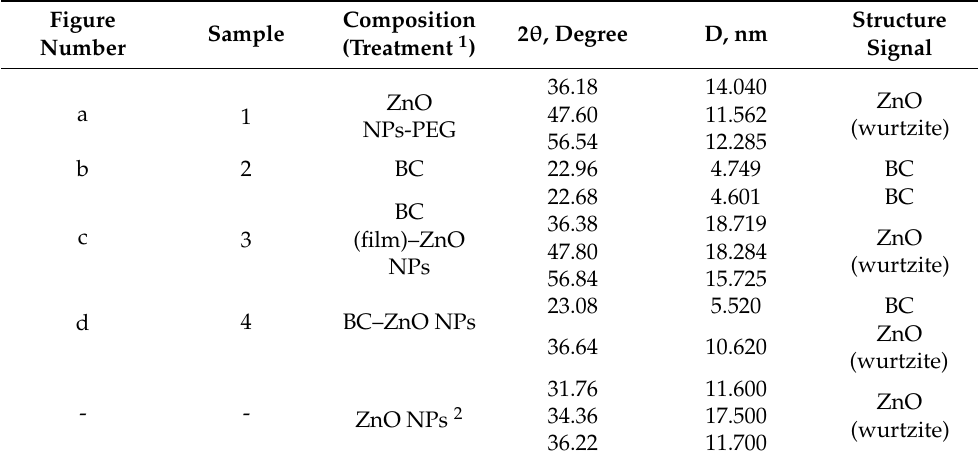
Table 2. Data of powder XRD patterns of BC-ZnO NPs samples (Figure 1). Figure 1. Powder XRD patterns of BC-ZnO samples: ( a ) ZnO NPs-PEG, ( b ) BC powder, ( c ) BC